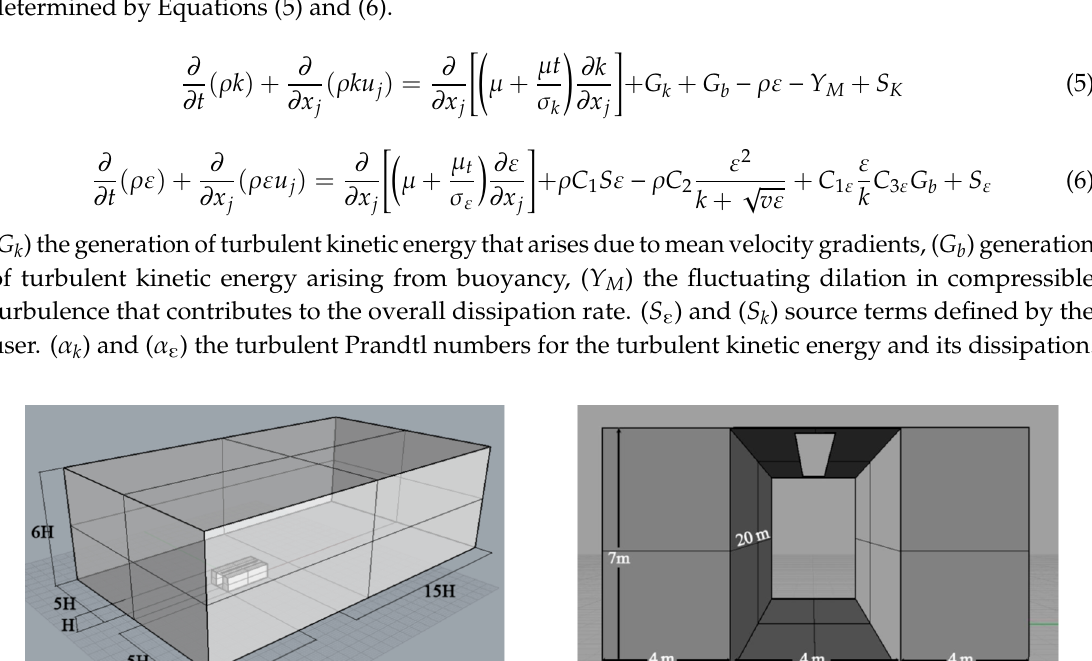
Table 1. Requisites for a consistent computational fluid dynamics (CFD) simulation [46,49,50] as applied on Figure 4.